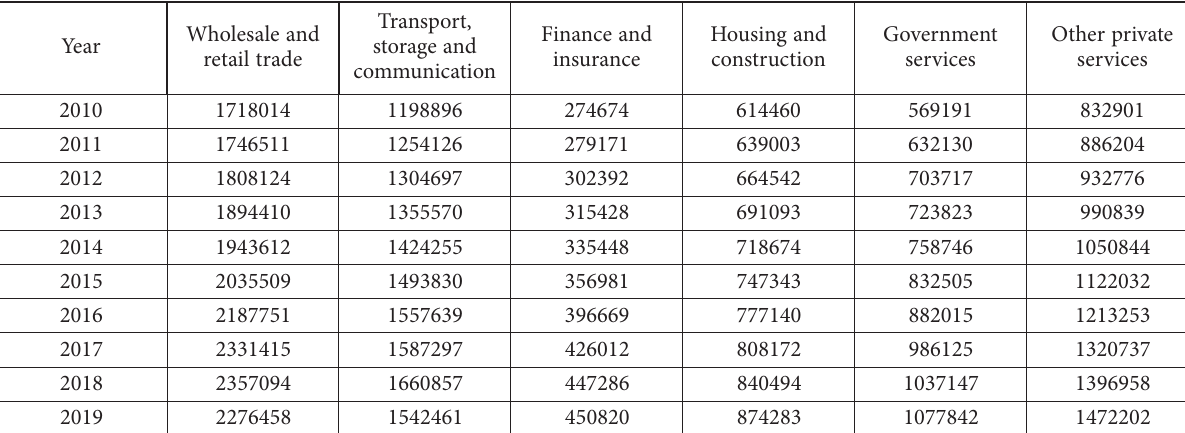
Table 3. Industrial sector disaggregation in the GDP of Pakistan (source: State Bank of Pakistan [SBP], n.d. All mounts are in PKRs (million))